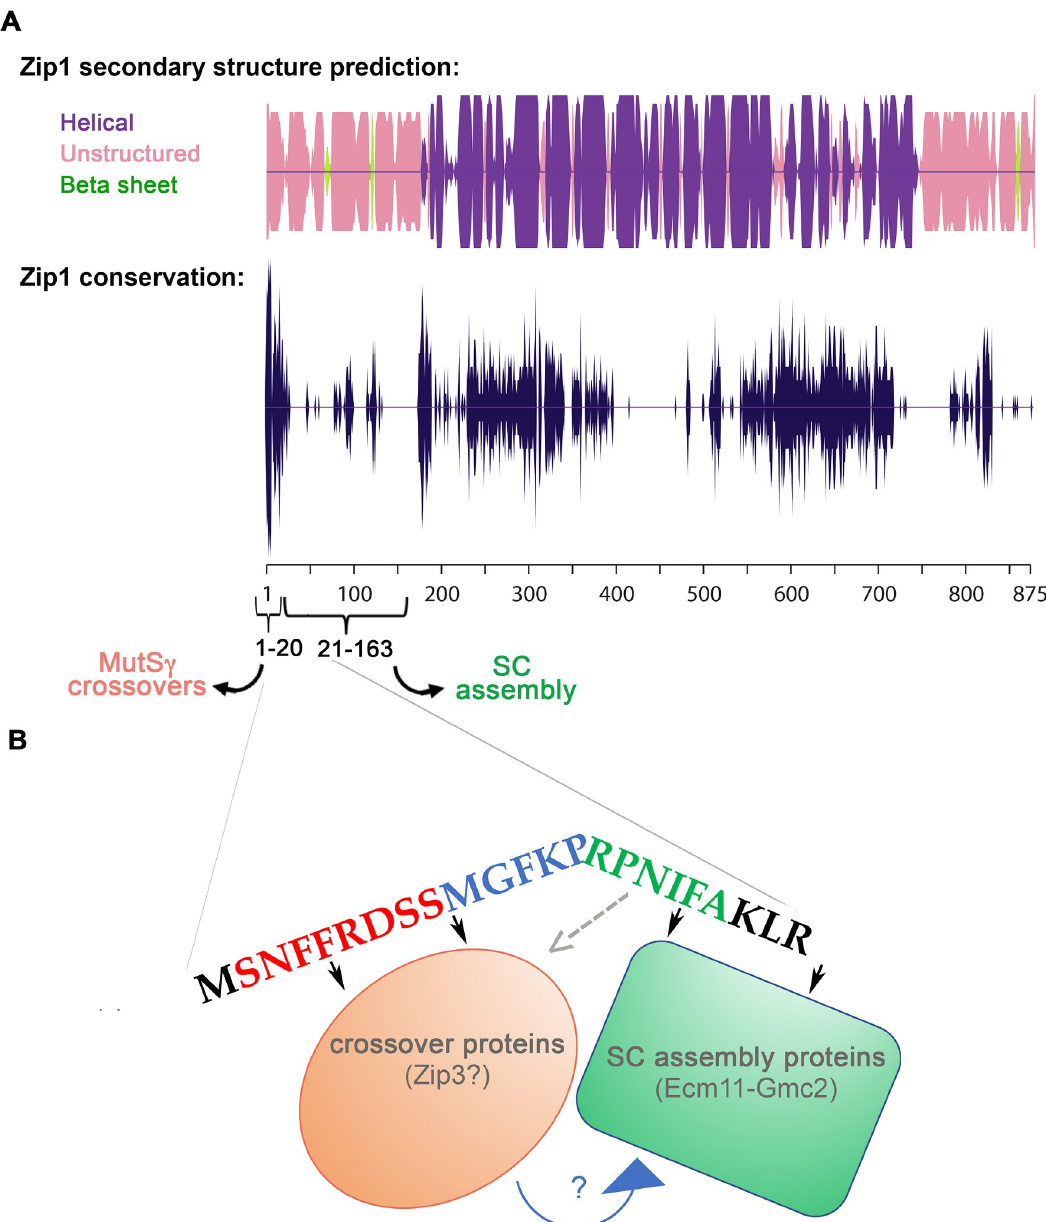
Fig 15. Adjacent conserved regions within Zip1’s N terminus coordinate meiotic crossing over with synapsis: A model . A) Cartoon illustrates the likelihood of the indicated secondary structure (alpha helical = purple; beta sheet = green; unstructured = pink) across the length of the 875 residue Zip1 protein. Secondary structure prediction was performed using JNet (http://www. compbio.dundee.ac.uk/www-jpred/). The lower line plot indicates the relative conservation of individual amino acid residues across the entire Zip1 protein, using homologs from the following 18 fungal species: Saccharomyces cerevisiae , Candida glabrata , Lachancea lanzarotensis , Tetrapisispora blattae , Tetrapisispora phaffii , Kazachstania naganishii , Vanderwaltozyma polyspora , Torulaspora delbrueckii , Zygosaccharomyces bailii , Zygosaccharomyces rouxii , Kazachstania africana , Naumovozyma dairenensis , Naumovozyma castellii , Kluyveromyces marxianus , Kluyveromyces dobzhanskii . Eremothecium cymbalariae , Ashbya gossypii , Ashbya aceri . Conservation scores are calculated in JalView 2.10 [67] based on multiple sequence alignment (http://www.jalview.org/help/html/ calculations/conservation.html). The conservation score is based on the physio-chemical properties of the amino acid residues and is given in arbitrary units from 0–11, where 11 is the most conserved (scores are listed in S6 Table). Stronger conservation is indicated by a longer line above and below the axis. The per-residue Jalview scores were plotted as an area graph in Excel and mirrored in Adobe Illustrator such that the amplitude of the plot signifies conservation: The maximum deviation from the center line indicates a maximum conservation (score = 11), whereas no deviation indicates no conservation (score = 0). Data plotted is listed in S6 Table. The cartoon in (B) illustrates the possibility that Zip1’s N terminal 20 residues represent adjacent functionalities: The